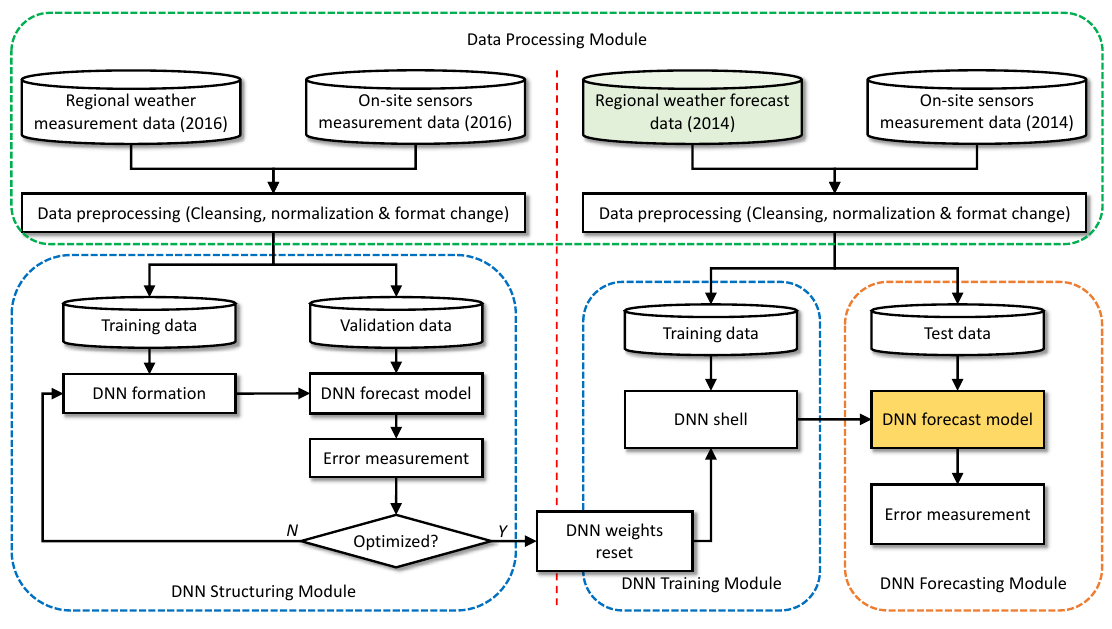
Figure 9. The procedure used in this